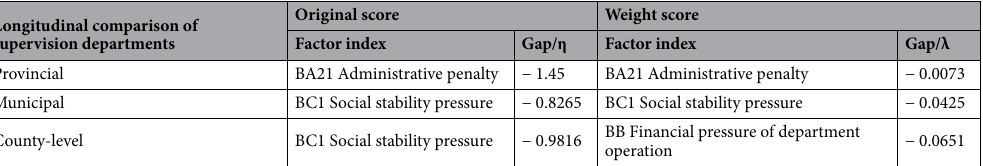
Table 20. Analysis of the shortcomings of the basic index scores of provincial, municipal and county-level supervisory departments (subsystem B)—longitudinal comparison.